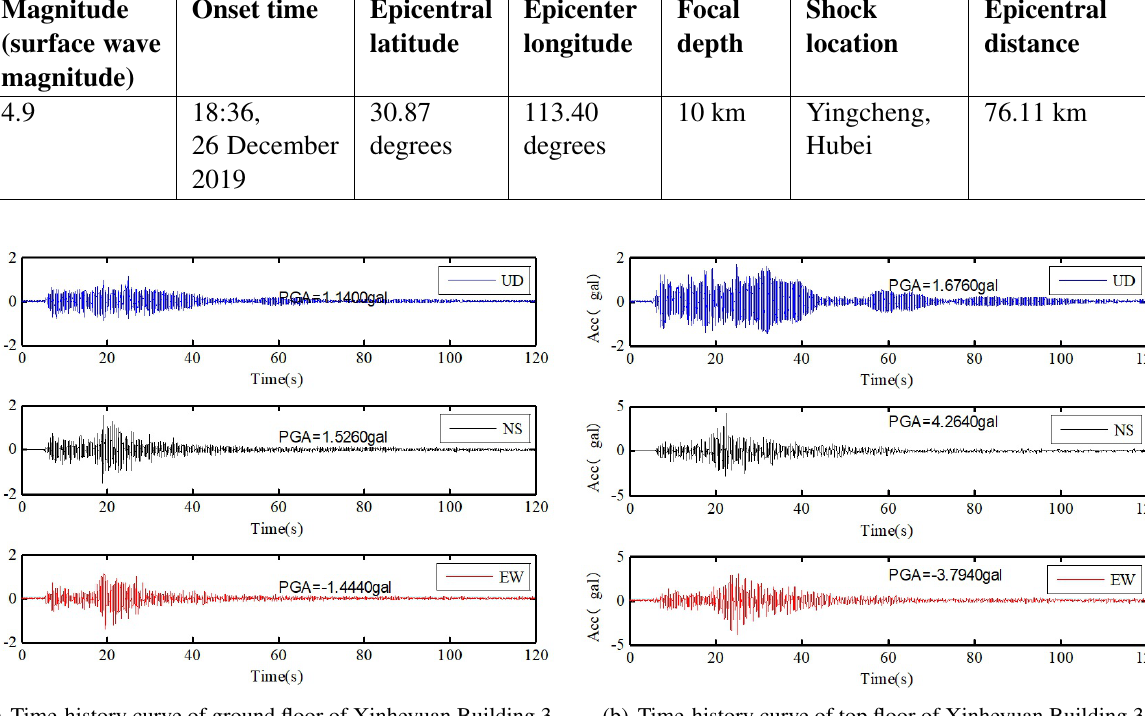
Table 1 Basic information on the earthquake in Yingcheng on 26 December 2019.